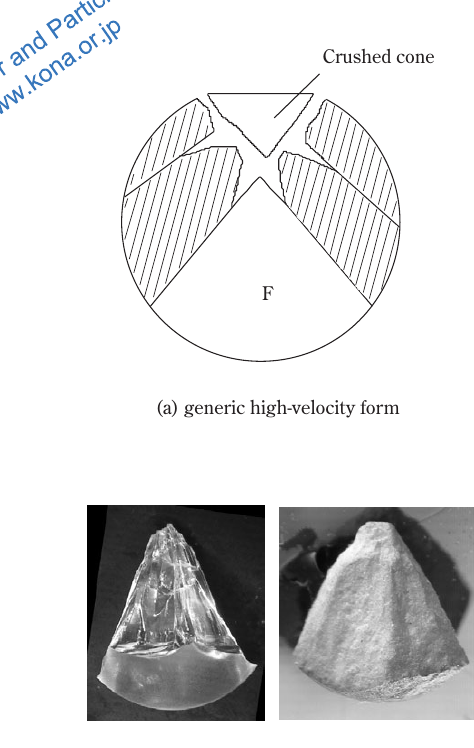
Fig. 4 High impact velocity regime failure patterns of several